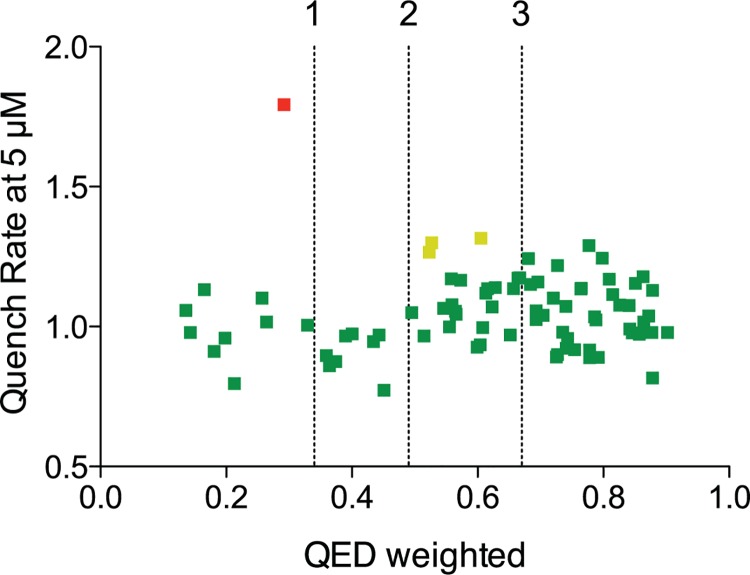
QED does not correlate with bilayer-mediated off-target effects.Plot of the quench rate (relative to control) vs. the weighted QED [43]. There is some clustering of the Malaria Box compounds toward the “attractive” QED value. MMV007384 (red dot, weighted QED = .292) is an unattractive complex compound. From L to R (amber dots): MMV020548 (weighted QED = .523) and MMV020548 (weighted QED = .527) are unattractive complex compounds; and MMV019258 (weighted QED = .605) is at the cusp of attractive and unattractive simple compounds. Vertical dotted lines represent reported averages of, from L to R: unattractive (complex); unattractive (simple); and attractive QED values. QED was calculated using Pipeline Pilot (Accelrys Inc., San Diego, CA). (Weighted QED did not differ substantially from unweighted QED, not shown).